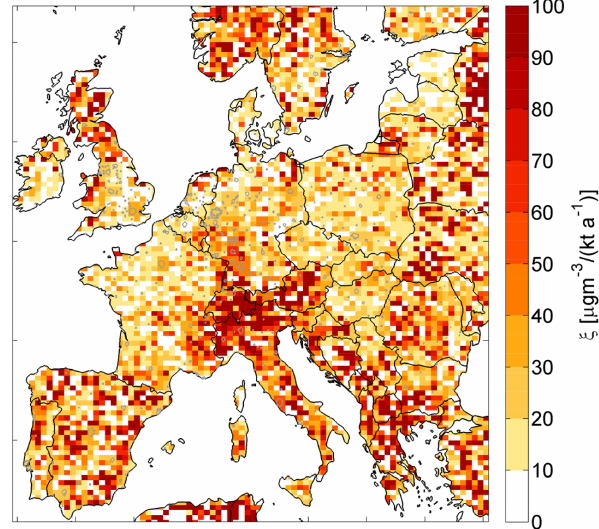
Figure 3. The regression coefficient ξ relating additional primary PM emissions within each EMEP grid cell to PM concentration in-